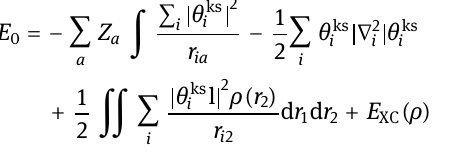
Table 3: Reaction thermodynamics and kinetic parameters Alkaline